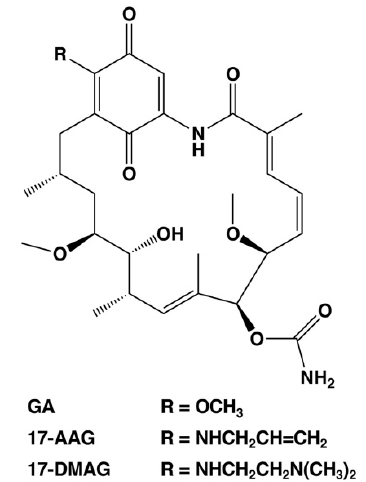
Figure 3. Chemical structures of selected HSP90 inhibitors. GA, geldanamycin; 17-AAG, 17-allylamino-17-demethoxy-geldanamycin (tanespimycin); 17-DMAG, 17-dimethylaminoethylamino-17-demethoxy-geldanamycin (alvespimycin).